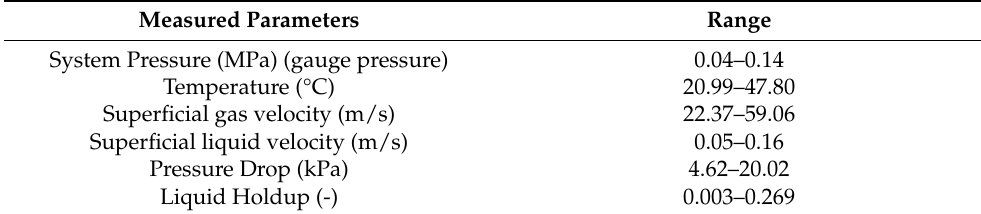
Table 3. Range of experimental data